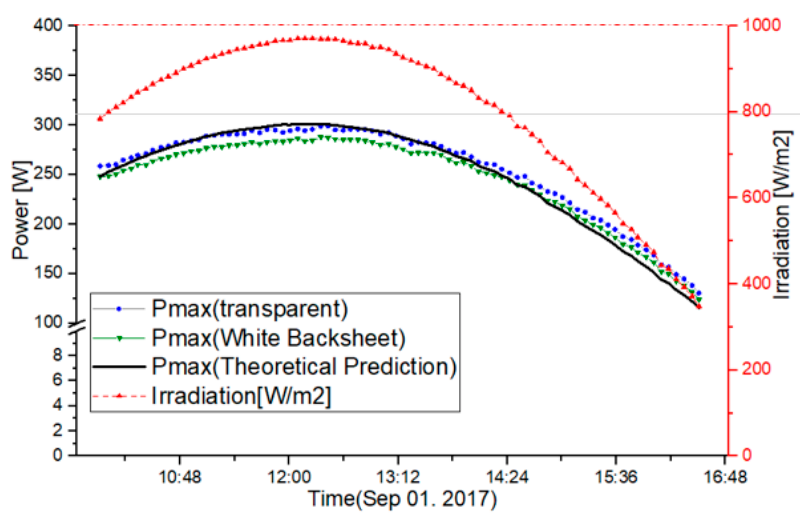
Figure 23. Output comparison between transparent and white back sheet on Exp. 6.